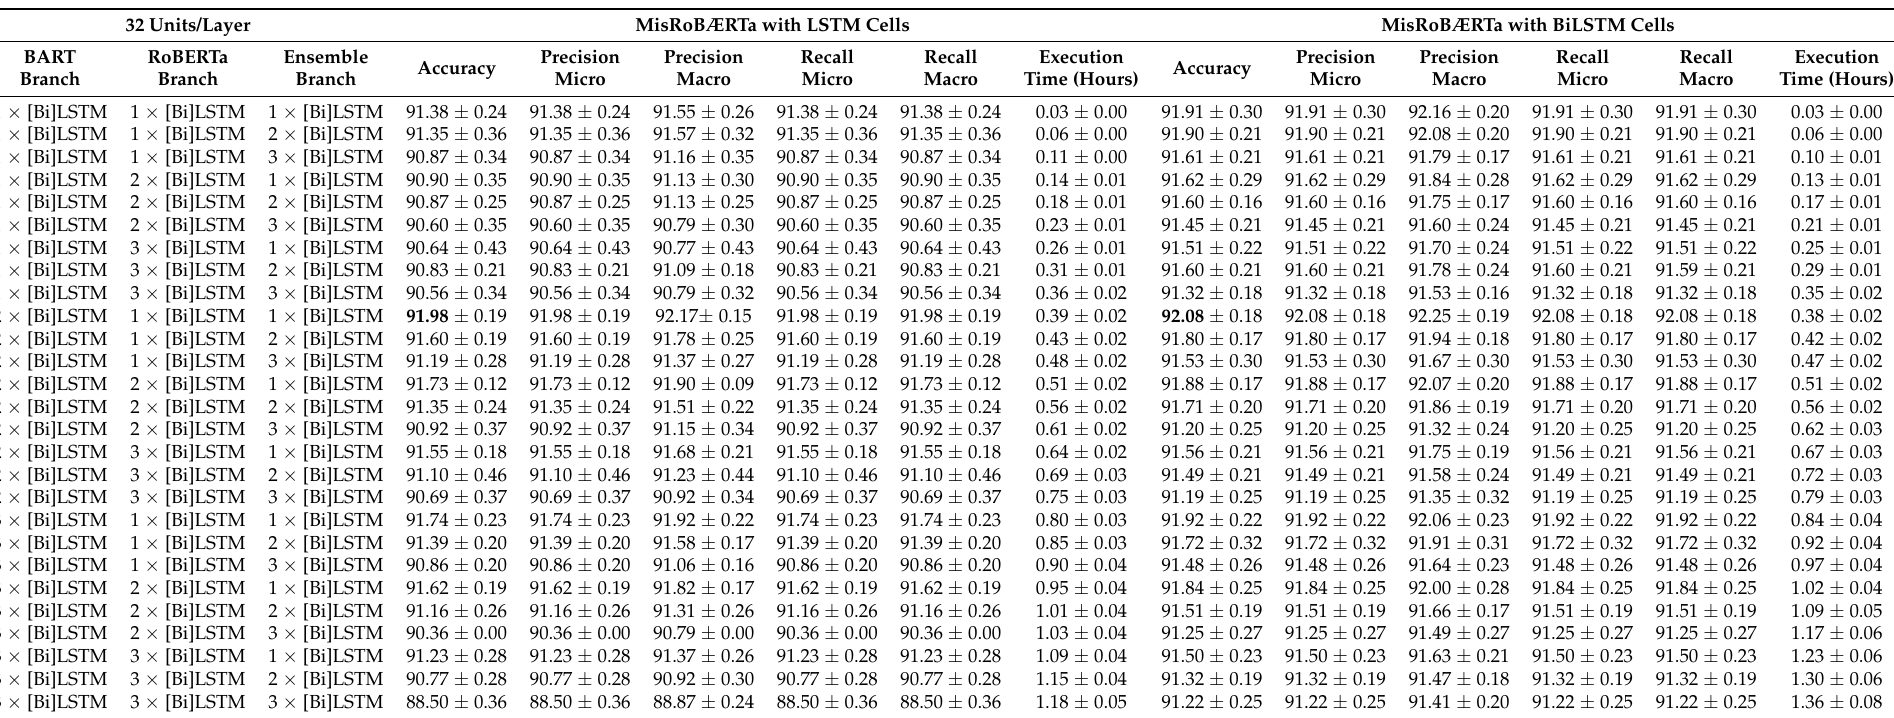
Table 8. MisRoBÆRTa ablation and sensitivity testing using the F AKE N EWS C ORPUS dataset presented in Section 5. (Note: bold text marks the overall best